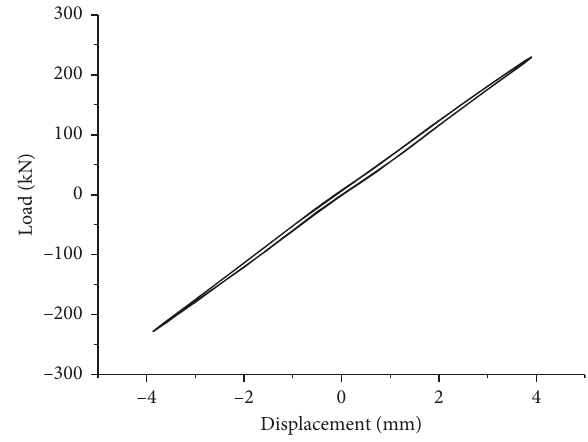
Figure 6: Typical energy dissipation